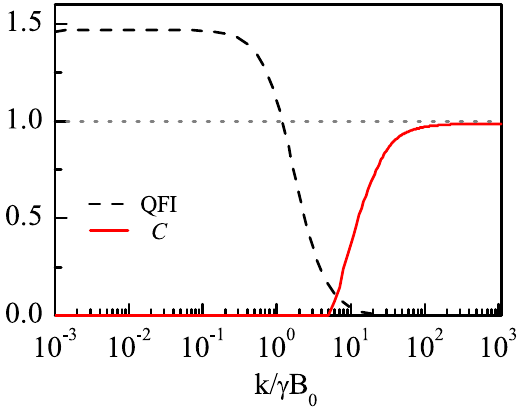
Figure 5. The QFI (black dashed line) and concurrence C (red solid line) as a function of the recombination rate k for µ = B 46 T and θ = π /4 with γ µ = × A 6 46 T, = = A A 0 0 z x y